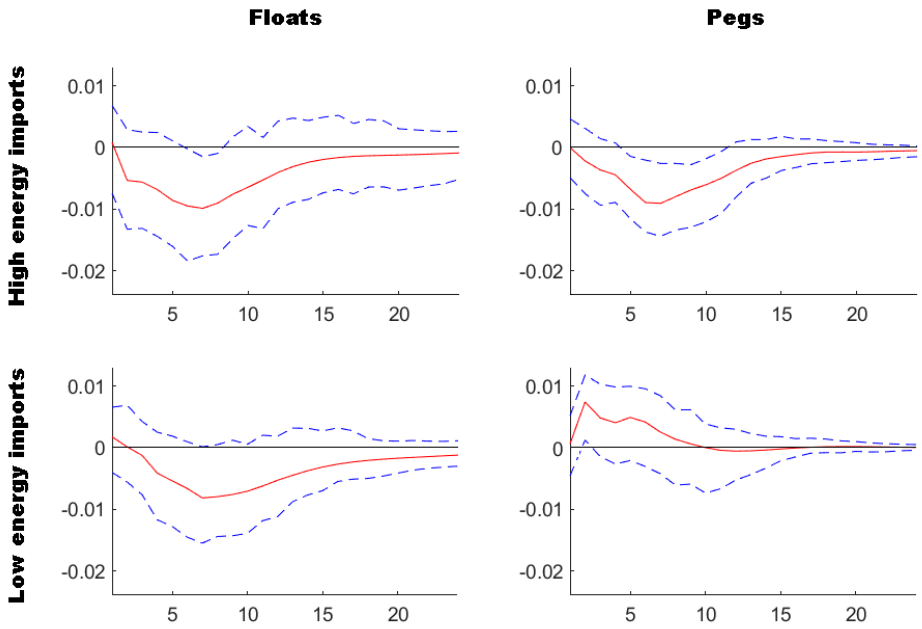
Figure 3. Impulse response functions with interaction terms of energy import dependency and exchange rate regime. Notes: the area between the dotted lines represents the 90% confidence interval.